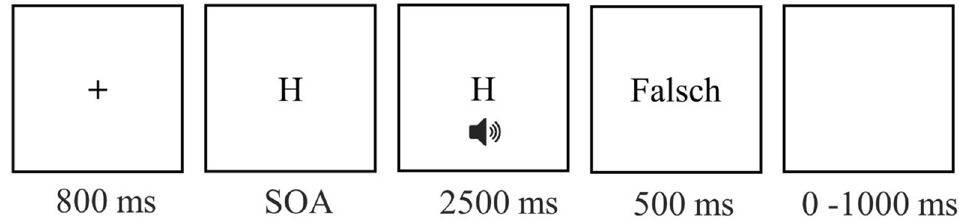
Figure 1. Trial procedure of the study. After the fixation sign, the visual stimulus for Task 1 (H or T) was presented. The auditory stimulus for Task 2 (high or low tone, represented by the speaker symbol) was delivered after one of three stimulus onset asynchronies (SOA, 40, 130, 300 ms). In the case of an erroneous response, feedback (i.e., “Falsch,” German for wrong) was presented.